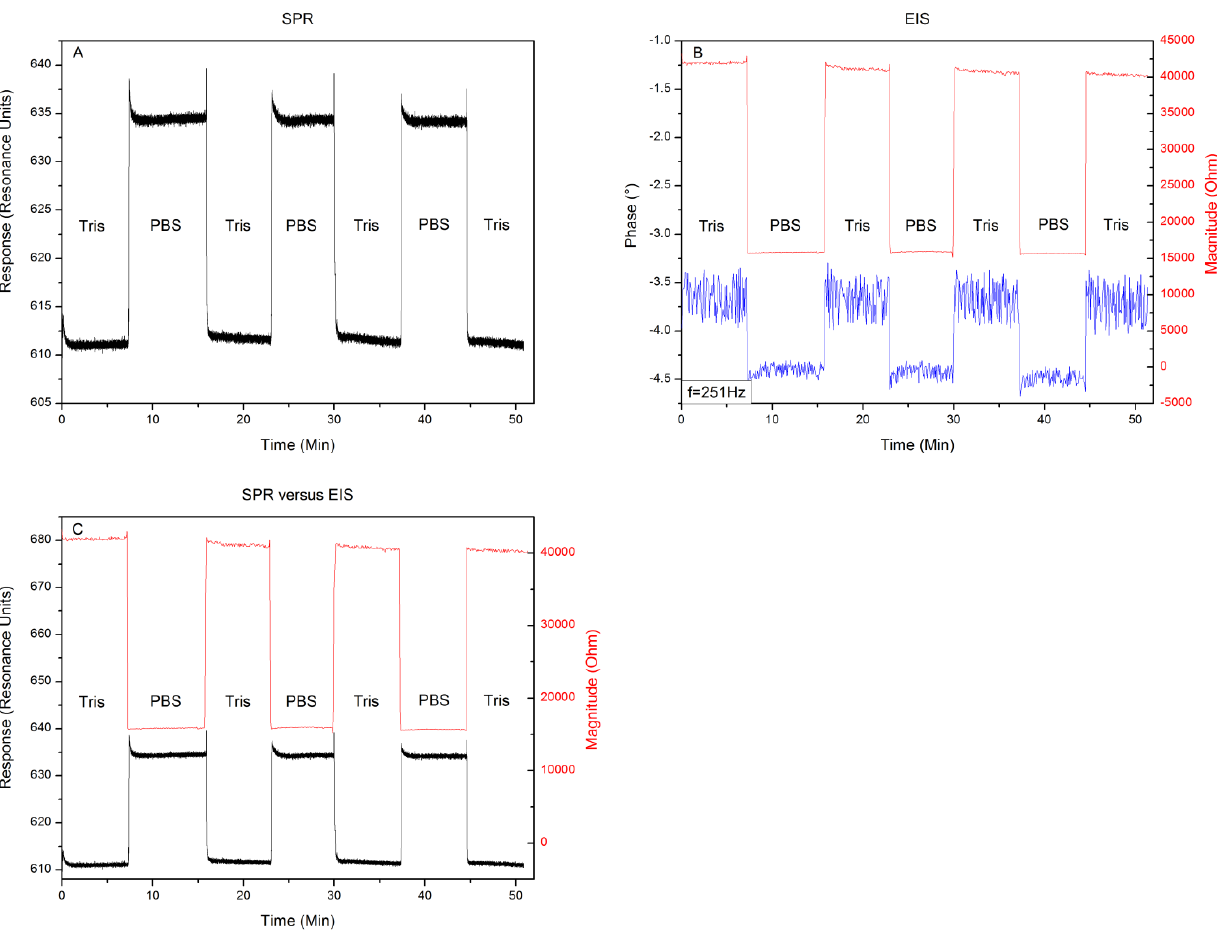
Figure 4. Alternating the media 10 mM Tris-HCl and 1× PBS buffer for three consecutive runs. ( A ) Shows the minimum shift when exchanging the media. ( B ) Illustrates the changes in amplitude and its phase at a frequency of 251 Hz, when exchanging the